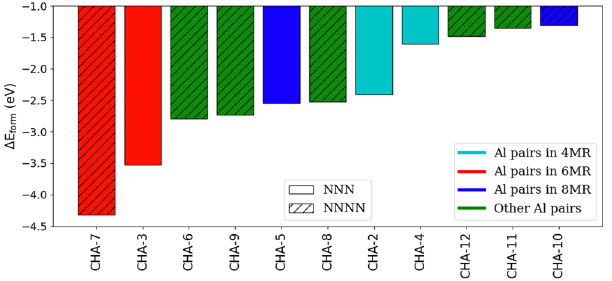
Fig. 4 Formation energy of Pd + 2 on CHA. Each bar represents unique Al location(s). Color coding refers to the type of Al pairs or isolated Al in the zeolite matrix. Solid bars refer to Al pairs in NNN con fi guration and striped bars refer to NNNN con fi guration. The two most stable sites (CHA-7 and CHA-3) are illustrated in Fig. 5.